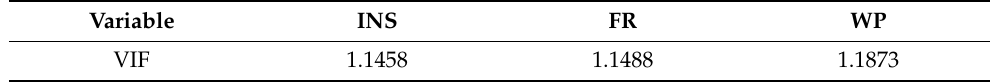
Table 9. Variance Inflation Factor (VIF) Test.